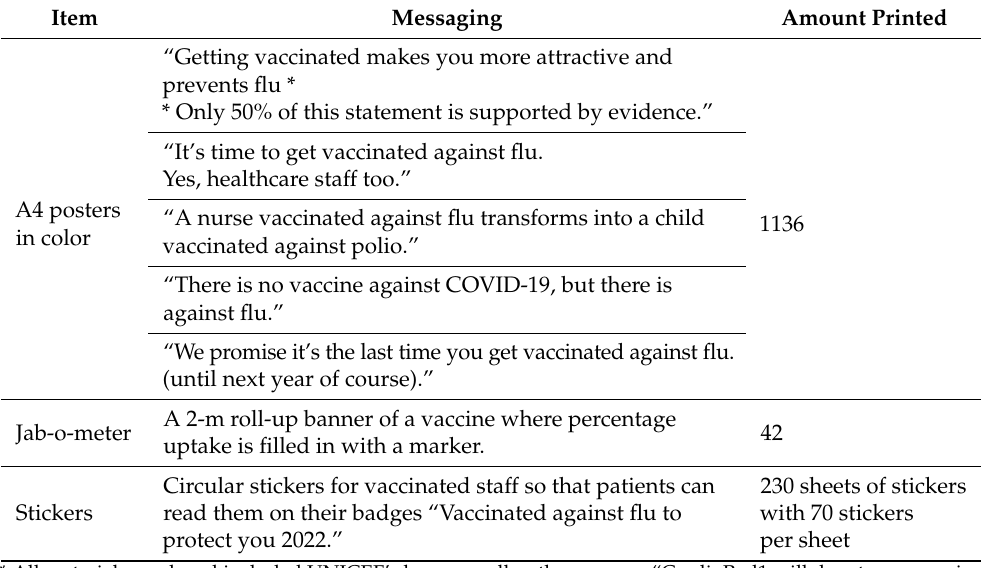
Table 1. Materials, messaging, and quantities sent to the primary care